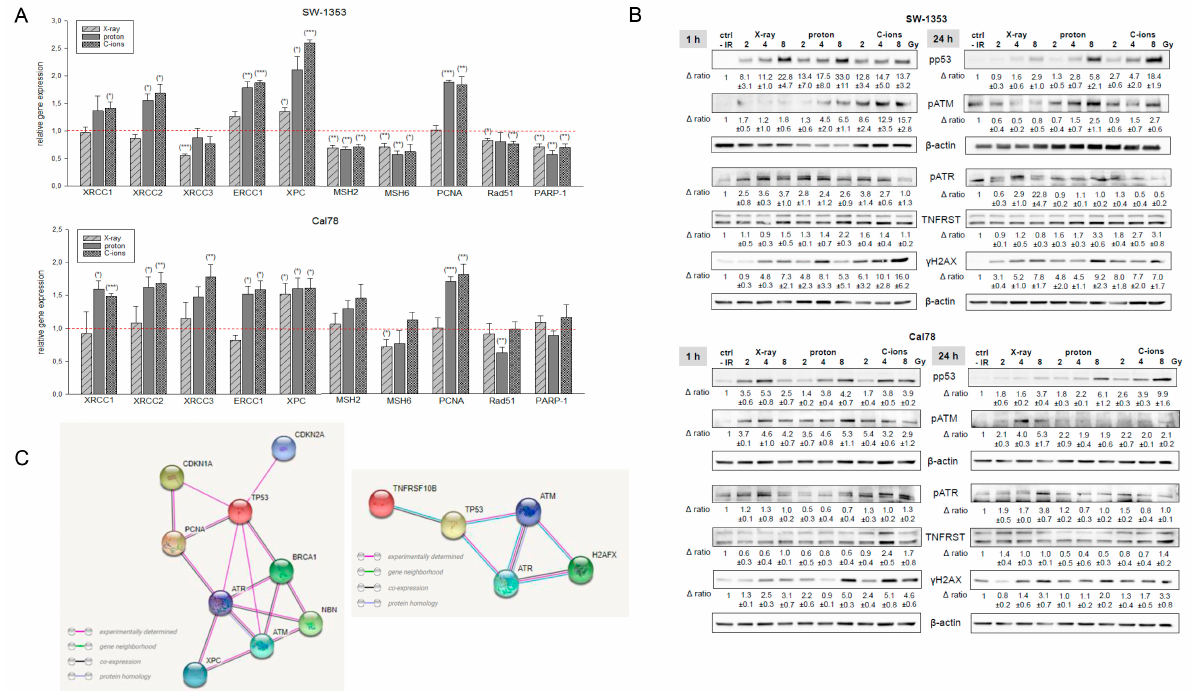
Figure 6. DNA repair key players. ( A ) Relative gene expression of XRCC1/2/3, ERCC1, XPC, MSH2/6, PCNA, Rad51, and PARP-1 24 h after treatment with 4 Gy X-ray (light grey striped), proton (dark gray), and C-ions (dark grey dotted) IR in SW-1353 and Cal78 chondrosarcoma cells (mean ± SD; n = 4; measured in triplicates). Non-IR cells were used as controls, which is represented by the red dotted line (ratio = 1). Statistical significances are defined as follows: * p < 0.05; ** p < 0.01; *** p < 0.001. ( B ) Protein phosphorylation pattern of SW-1353 and Cal78 chondrosarcoma cells. The influence of IR on protein phosphorylation of p53, ATM, ATR, the TNF receptor TNFRST10B, and the DNA damage marker γ H2AX was evaluated by immunoblotting under non-IR control conditions (ctrl) and 1 and 24 h after 2, 4, and 8 Gy X-ray/proton/C-ion IR. β -actin was used as loading control. Δ ratio, fold change normalized to non-IR controls (mean ± SD of n = 3). ( C ) The STRING database interaction network revealed the relationship of the most relevant cell cycle and DNA repair gene.